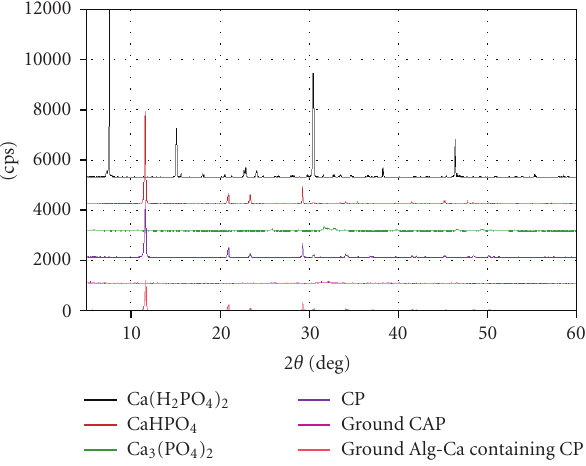
Figure 3: X-ray di ff ractograms. (1) Ca(H 2 PO 4 ) (4) CP (5) ground CAP (6) ground Alg-Ca containing Ca 3 (PO 4 ) 2